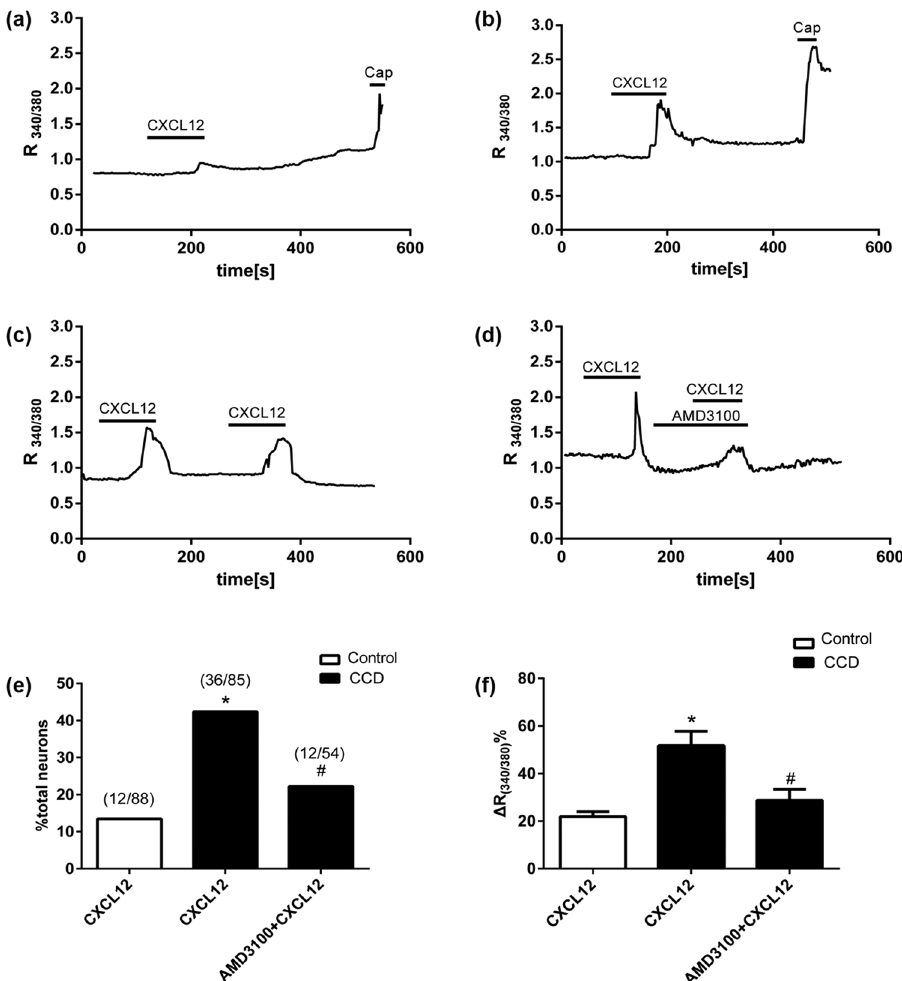
Figure 4. CXCL12 induced [Ca 2 + ] i increase through neuronal CXCR4 in the dissociated DRG neurons from CCD mice on postoperative day 7. Black bars above the traces indicate the timing of chemical application. Representative trace showing that CXCL12-induced changes in [Ca 2 + ] i (R (340/380) ) in neurons from CCD mice ( b ) was significantly greater than that in neurons from control mice ( a ). ( c , d ) In the presence of AMD3100, the rise in [Ca 2 + ] i evoked by CXCL12 was significantly less than that in the control medium without antagonist. ( e ) Quantification of the percentage of DRG neurons that responded to CXCL12, Few (12 of 88 cells, 13.48%) DRG neurons from control mice (n = 6) responded to CXCL12 (100 nM). In contrast, there were more (36 of 85 cells, 42.35%) neurons responed to CXCL12 in CCD mice (n = 8), Also, the percentage of CXCL12 responsive neurons from CCD mice was decreased in the presence of AMD3100 (12 of 54 cells, 22.22%, n = 8). * P < 0.05 vs. (Control + CXCL12) group, # P < 0.05 vs. (CCD + CXCL12) group, Chi-square test. Numbers of neurons tested are given in parentheses. ( f ) Quantification of changes( Δ ) in [Ca 2 + ] i R (340/380) among responsive neurons. Changes in [Ca 2 + ] i R (340/380) was significantly greater for neurons from CCD than from control mice. AMD3100 attenuated CXCL12-induce change in [Ca 2 + ] i R (340/380) in neurons form CCD mice, * P < 0.05 vs. (Control + CXCL12) group, # P < 0.05 vs. (CCD + CXCL12), one-way ANOVA followed by Tukey’s post hoc